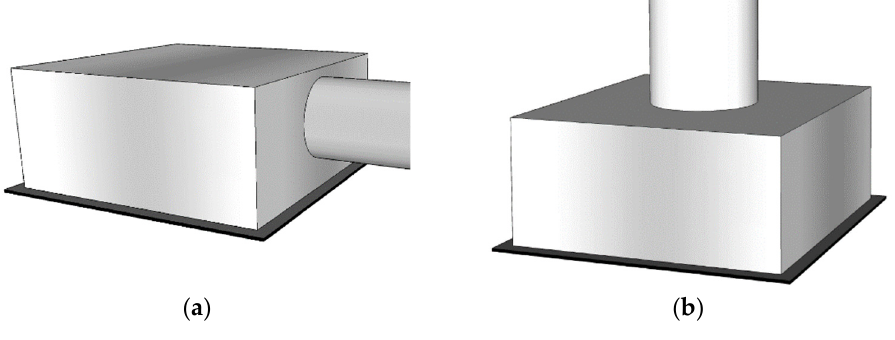
Figure 1. Plenum box with ( a ) side entry; ( b ) top entry.